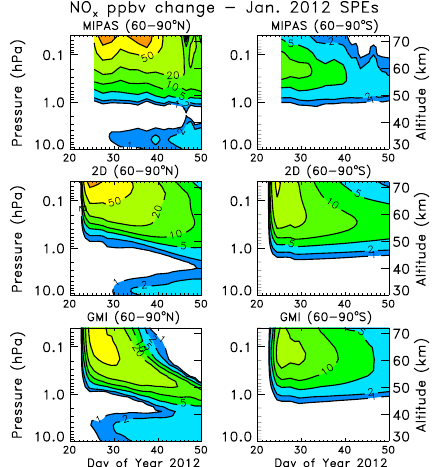
Fig. 8. Daily averaged NO x (NO + NO 2 ) changes from DoY 22 (22 January) 2012 values for 60–90 ◦ N ( left plots ) and 60–90 ◦ S ( right plots ) as measured by MIPAS ( Top ) and calculated by the GSFC 2-D model ( Middle ) and the GMI 3-D CTM ( Bottom ). The contour intervals for the NO x differences are 1, 2, 5, 10, 20, 50, and